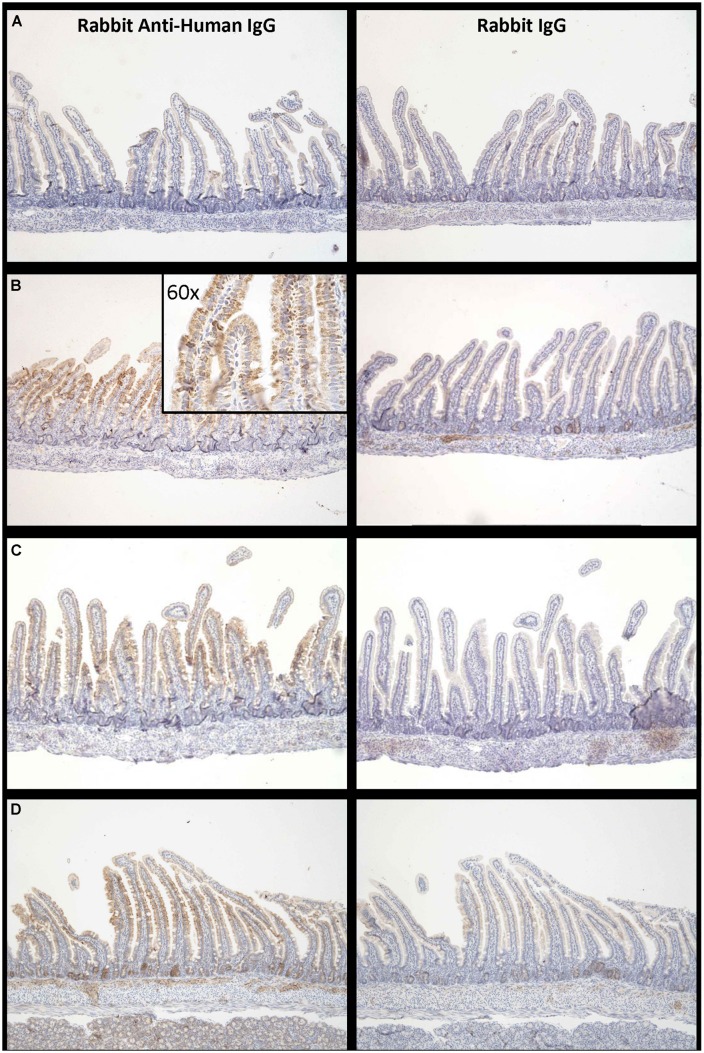
Increased levels of IgG bound to enterocytes at pH 6.0 compared to pH 8.0: Representative examples of IgG –immuno-reactivity in enterocytes of suckling rat pup proximal small intestine 90 min after administration of (A) PBS, (B) IgG1 N434A at pH 6.0, (C) IgG1 N434A at pH 8.0, and (D) IgG1 H435A at pH 8.0. Images on the left-hand side are using rabbit anti-human IgG, and the images on the right are using the anti-rabbit IgG to show specificity. Images are at 10× magnification with the exception of the inserted image in (B) which is 60× magnification.